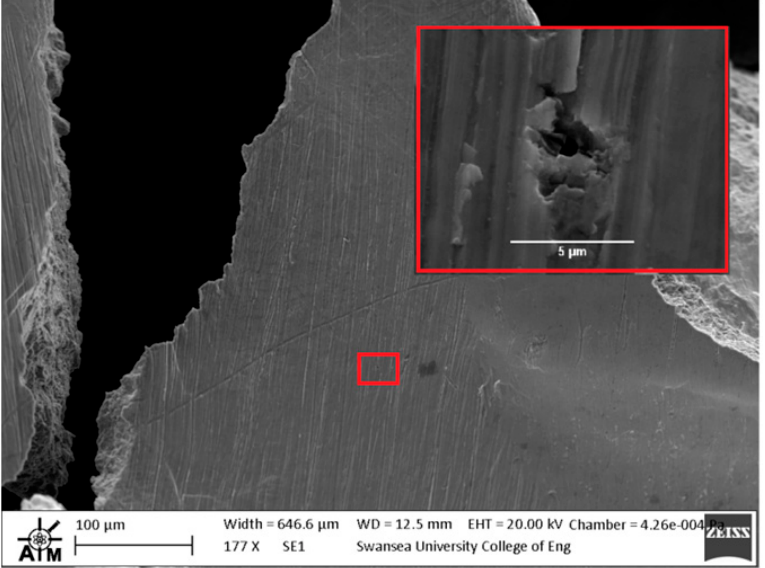
Figure 18. SEM image of the surface breaking pore highlighted in Figure 17 by XCT.